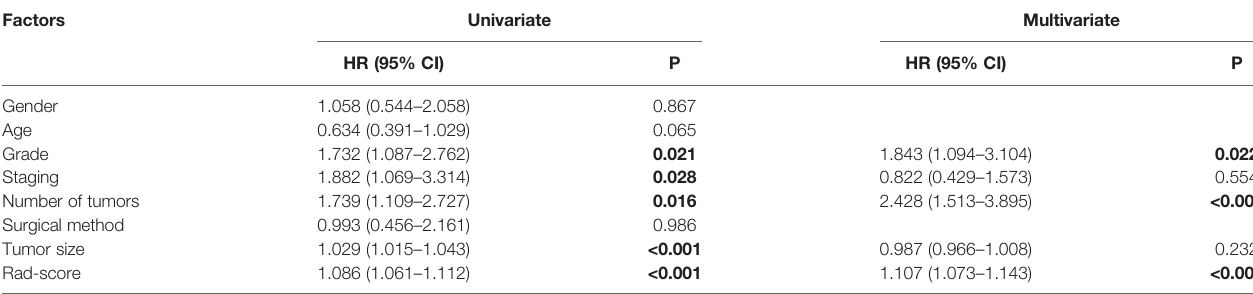
Bold indicates statistical signi fi cance at the level of P